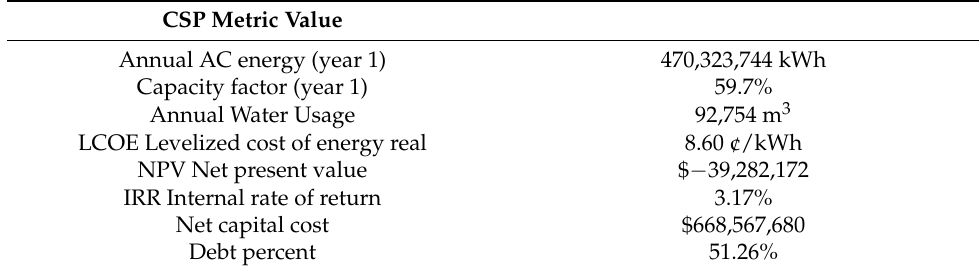
Table 6. CSP plan SAM model summary metric